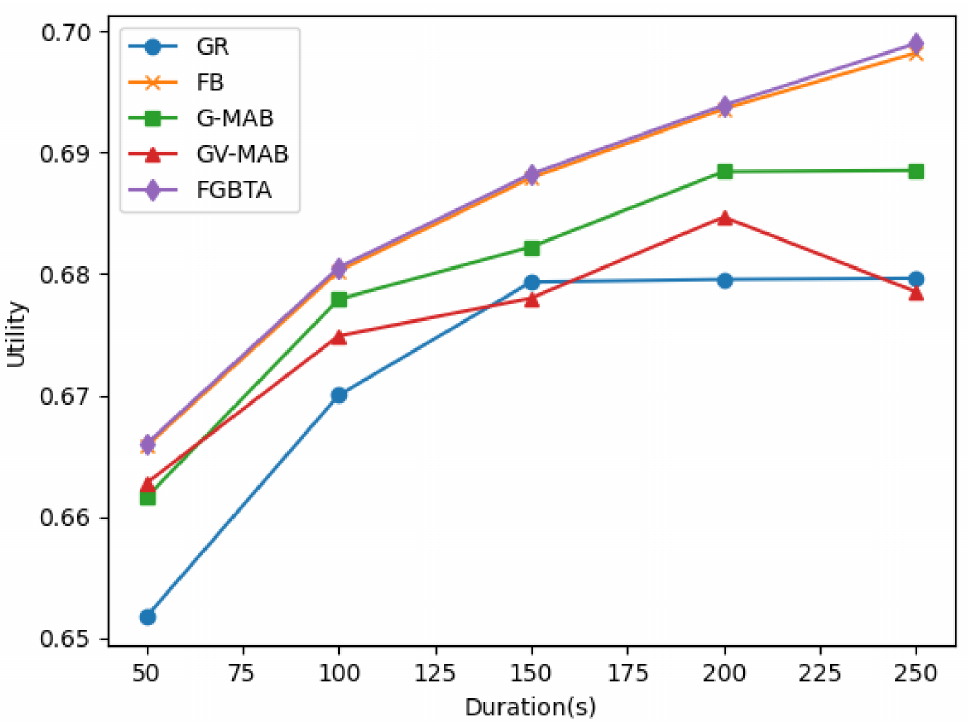
Figure 5. Utility of varying duration.